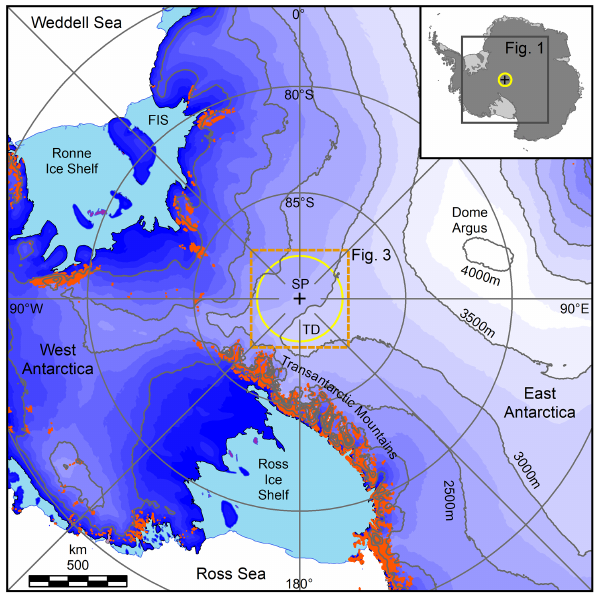
Figure 1. Location map with survey area around 88 ◦ S (yellow line). Surface elevation is from Helm et al. (2014a). Rock outcrops from the Antarctic Digital Database are marked in red. SP marks the geographic South Pole, TD is Titan Dome, and FIS is Filchner Ice